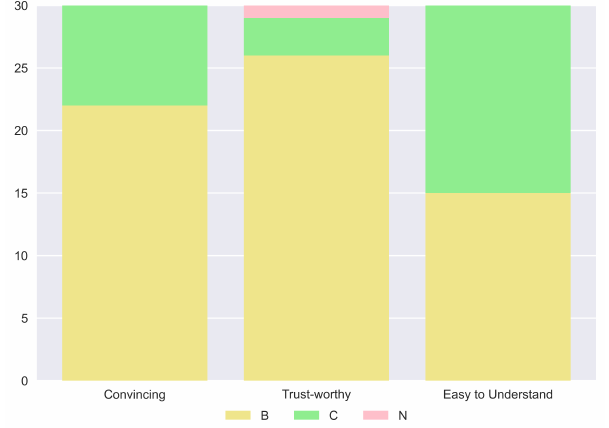
Figure 24. Bar chart of the preferences for counterfactual explanations chosen by the participants for three different